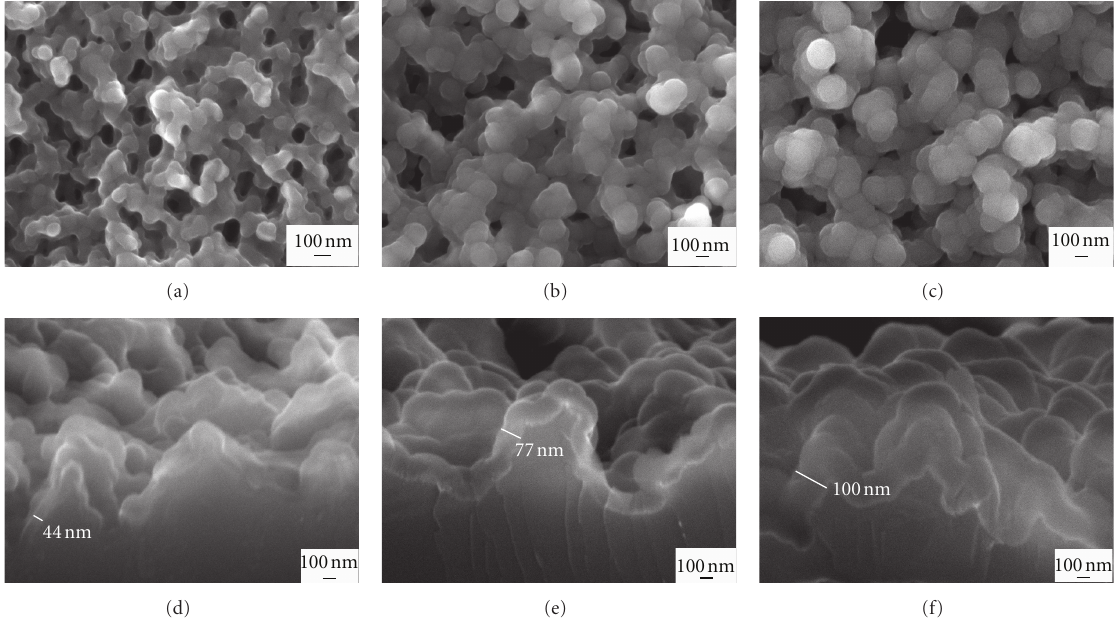
Figure 8: The microstructure of SiN film varying with deposition time, Top view: (a) 300 s, (b) 500s, and (c) 700 s, Side view: (d) 300s, (e) 500s, and (f)